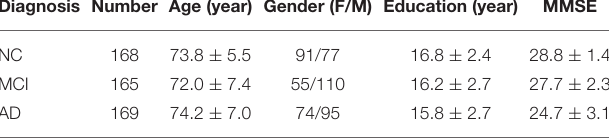
TABLE 1 | Demographic